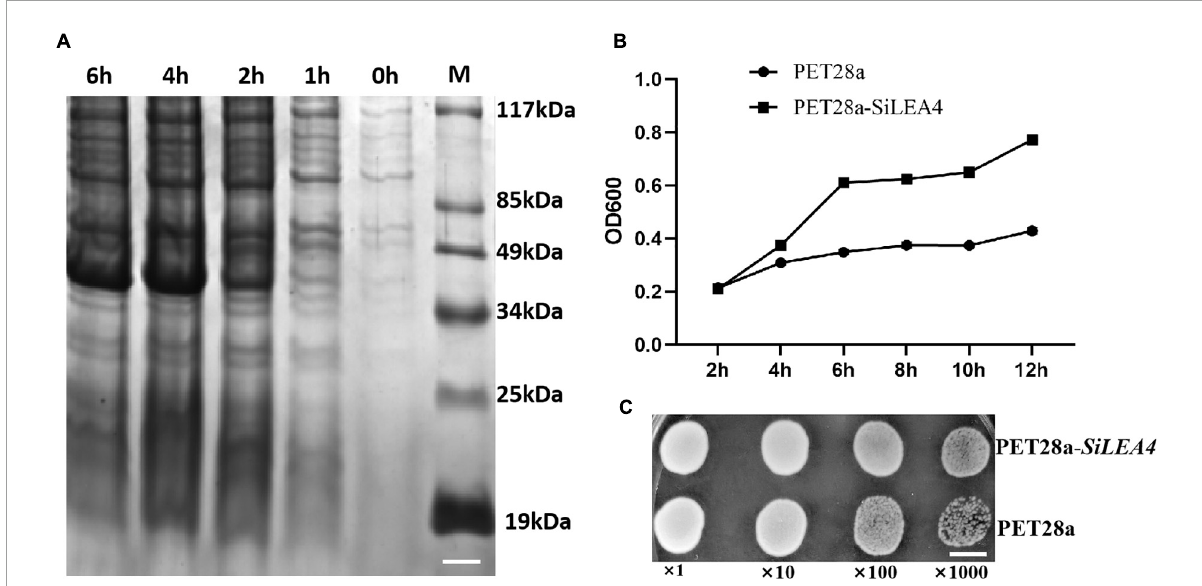
FIGURE2 Functional analysis of SiLEA4 overexpression in Escherichia coli BL21 for low temperature tolerance. (A) Induced expression of the SiLEA4 (PET28a- SiLEA4 ) protein in E. coli . 0, 1, 2, 4, 6 h: the IPTG induction times, respectively. M . low molecular-weight protein marker. Bar = 1 cm. (B) Growth kinetics of E. coli transformed with PET28a (control) and PET28a- SiLEA4 . The bacteria were cultured at 4 ◦ C and 180 rpm. The OD600 values were measured every 2 h to evaluate the growth conditions. (C) The growth performance of E. coli DE3 (PET28a, upper)/(PET28a-SiLEA4, down) after stress –2 ◦ C. The cell cultures were adjusted to OD600 = 1. Cells were growth on –2 ◦ C for 24 h and were then diluted serially (1:10, 1:100, 1:1000). Two microliters of each sample was spotted onto the LB plates and then incubated for 8 h for 37 ◦ C. Bar = 80